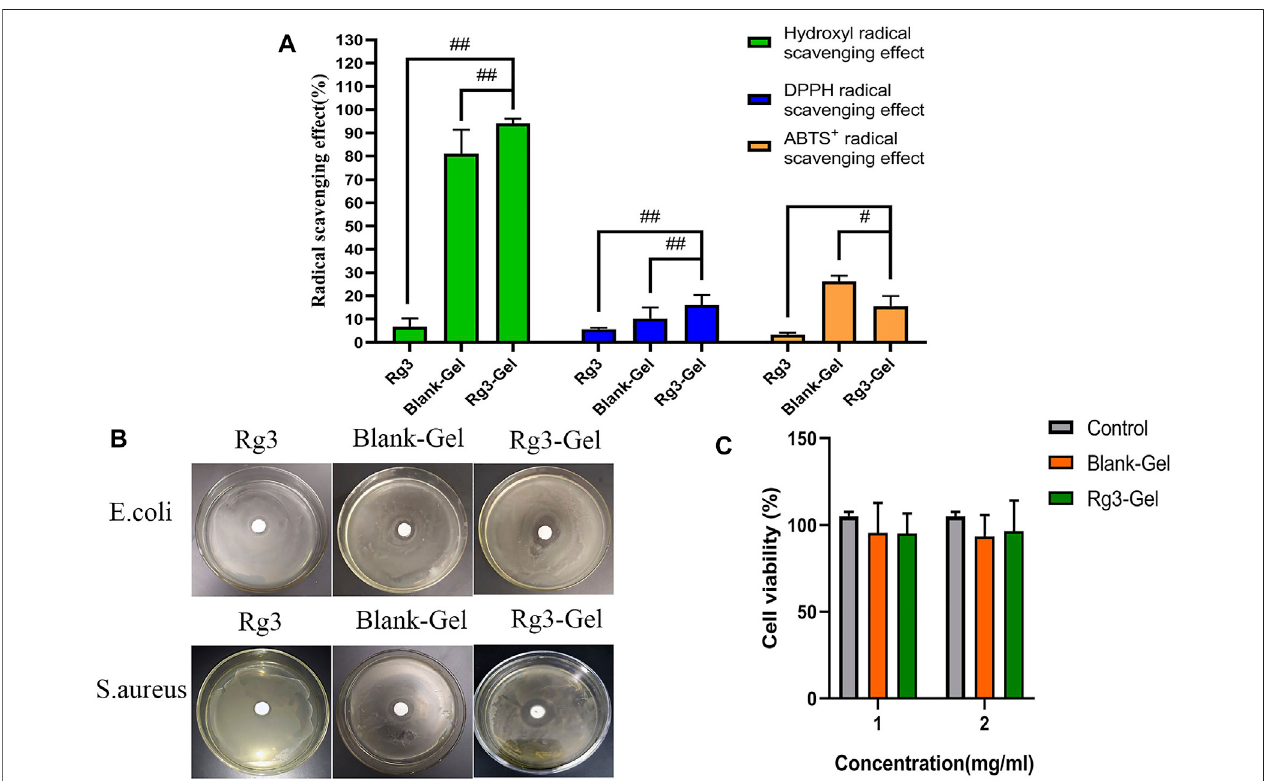
FIGURE3| Antioxidant,antibacterialability,andcytotoxicityofRg3-Gel. (A) EachradicalscavengingpropertyoftheRg3,Blank-Gel,andRg3-Gel( # p < 0.05, ## p < 0.01, and n = 3). (B) Antibacterial inhibition zones of the Rg3, Blank-Gel, and Rg3-Gel for S. aureus and E. coli , respectively ( n = 3). (C) Cell viability of human HaCaT keratinocytes (MTT assay) treated with Rg3-loaded Rg3-Gel and Rg3-unloaded Blank-Gel samples; data represent average of fi ve experiments ±SD ( # p < 0.05, ## p < 0.01, and n =